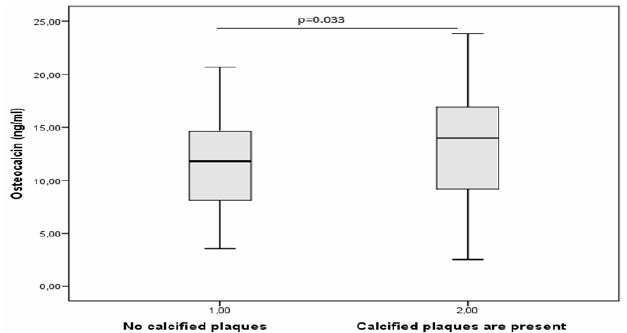
Figure 4. Concentration of osteocalcin in the blood of males with coronary atherosclerosis, depending on the presence of calcification deposits in atherosclerotic plaques.